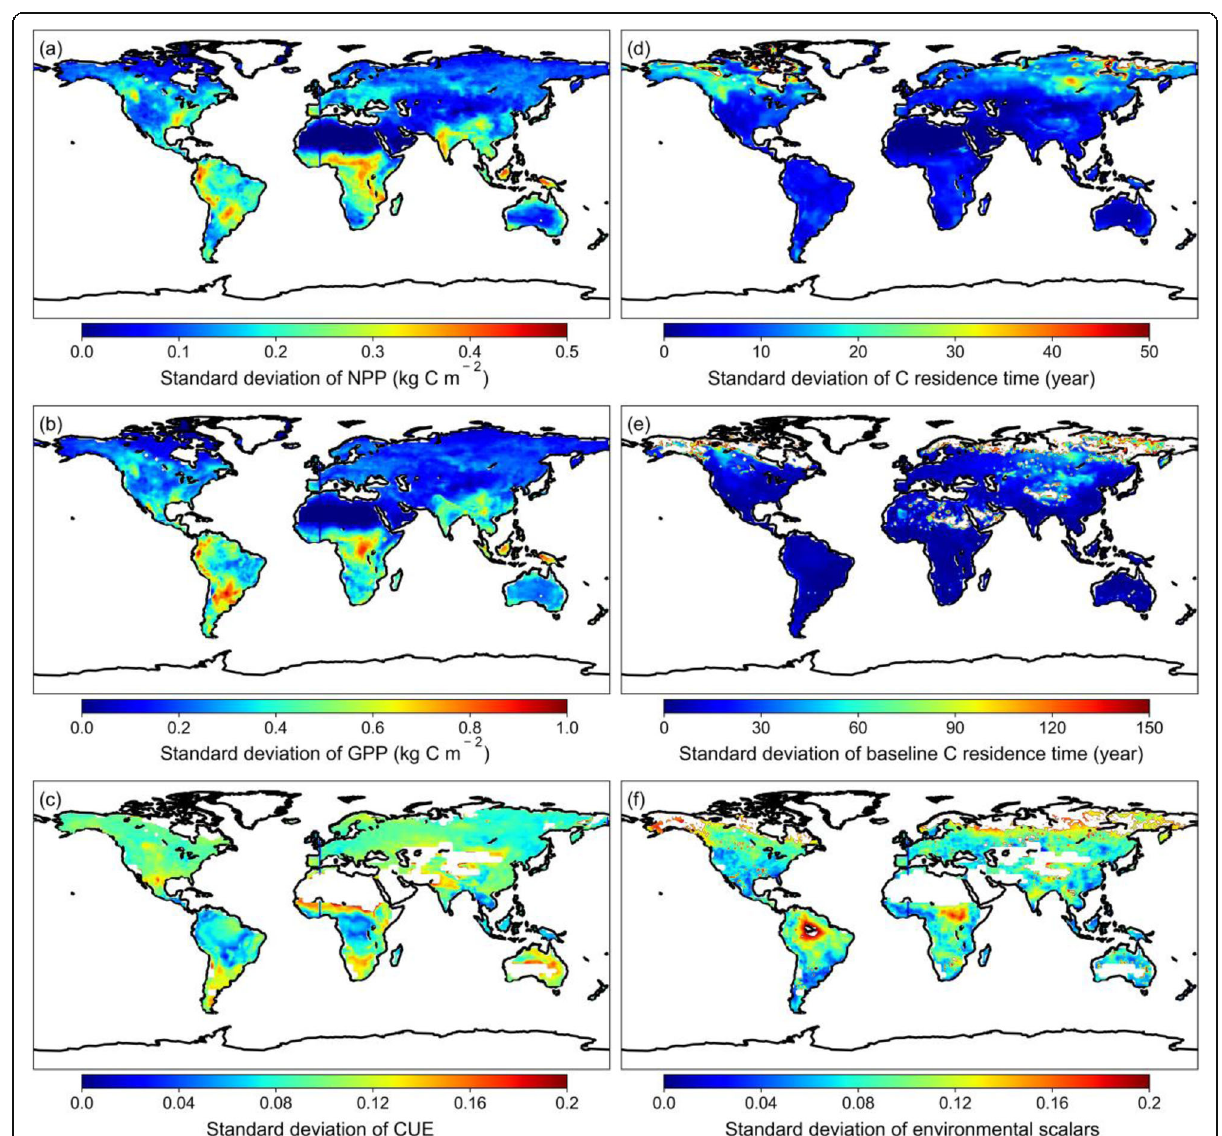
Fig. 8 The global distribution of the variations of the traceable variables simulated by seven models from CMIP6 for the historical period of 1850 – 2014. a – f The standard deviation of net primary productivity (NPP), gross primary productivity (GPP), carbon use efficiency (CUE), carbon residence time, baseline carbon residence time, and environmental scalars,